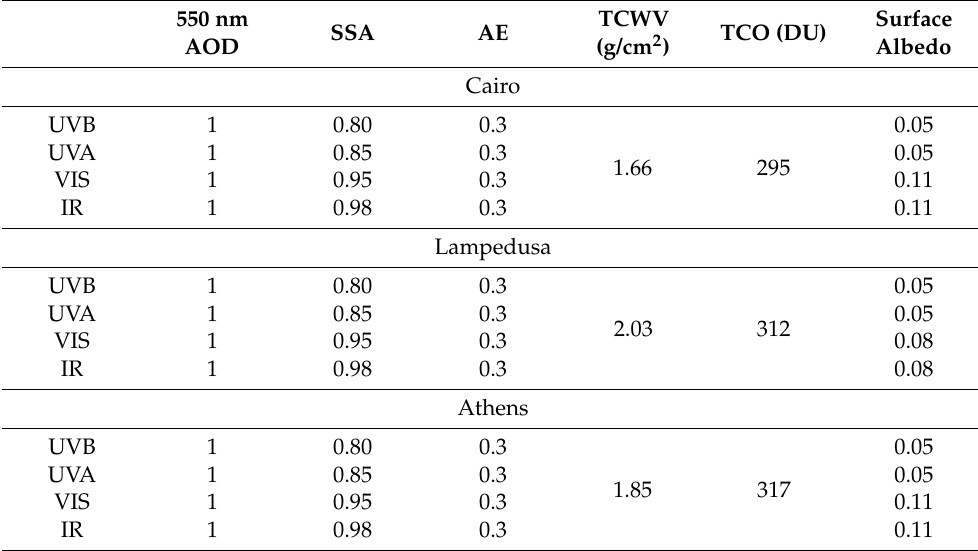
Table 5. TCO, TCWV, surface albedo and aerosol optical properties (AOD at 550 nm, SSA, AE) used in the simulations for Cairo, Lampedusa and Athens AOD at 550 nm. 550 nm SSA AOD